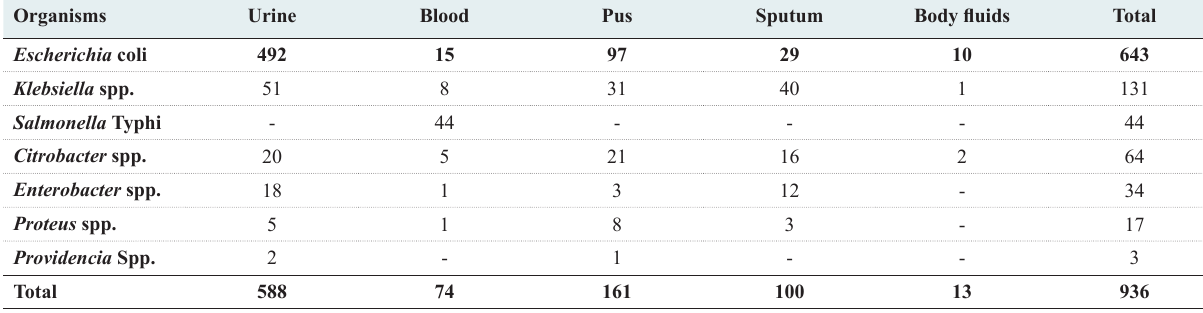
Table 1: Prevalence of Enterobacteriaceae isolates from different clinical samples